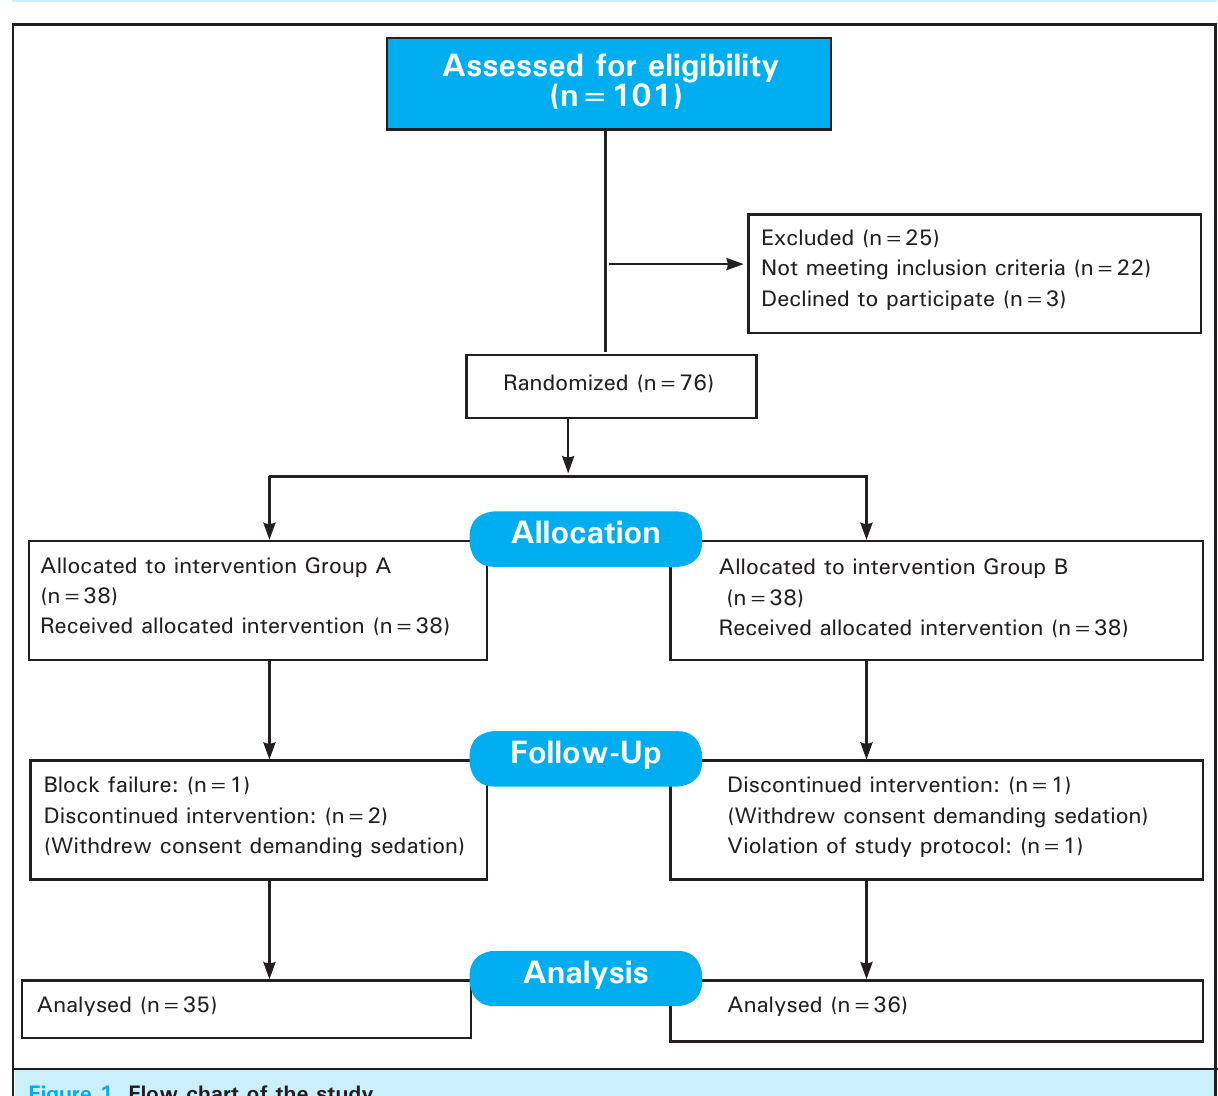
Figure 1. Flow chart of the study.